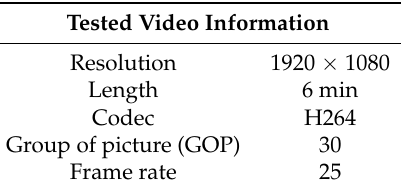
Table 2. Video test sequence.